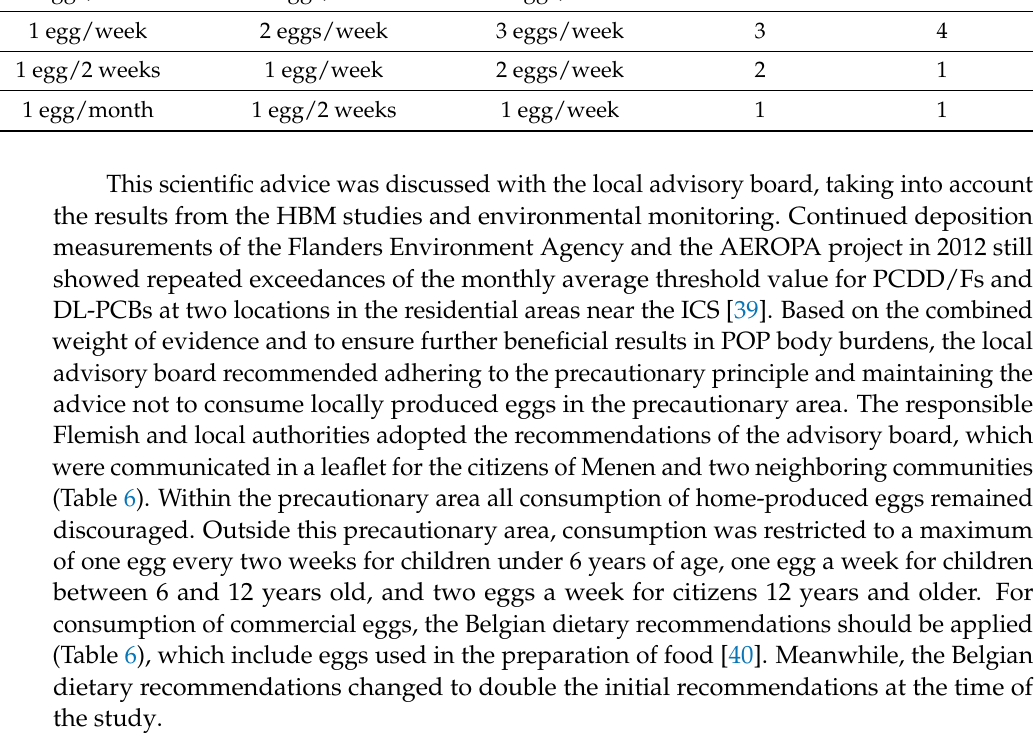
Table 6. Policy recommendations on safe consumption of home-produced eggs in the Menen region, translated from the Dutch leaflet for citizens.